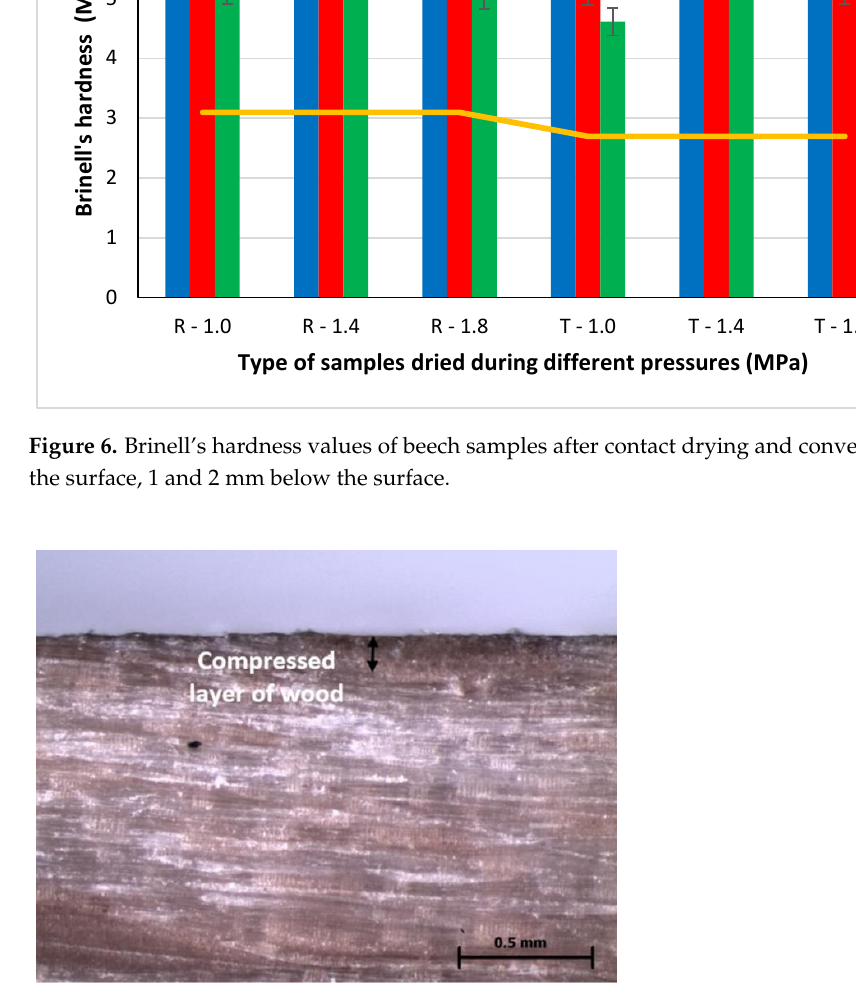
Figure 7. Microscopic view of the differently coloured surface layers of beech wood after contact drying at 60× magnification (type of microscope LEICA MZ 95).